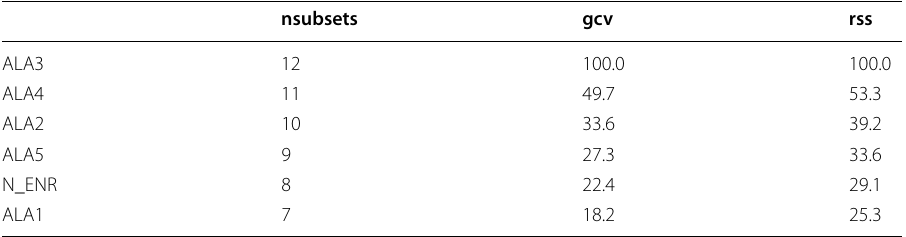
Table 15 Variable relative importance on Introduction to enterprise MARS model